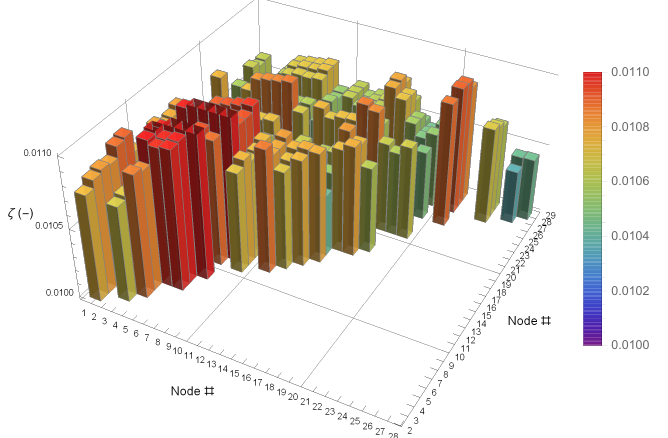
Figure 14. IEEE 39 bus: Damping ratios for synchronverters connected to different